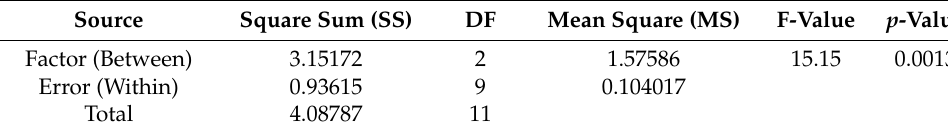
Table 10. Effect of P2 fiber type and temperature on f L by applying ANOVA analysis.